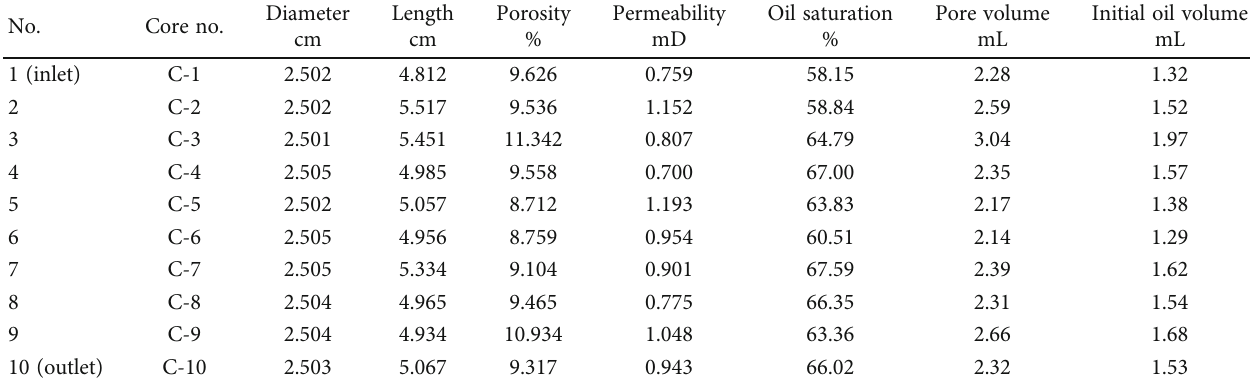
Table 1: Core sequencing results in long core displacement experiment.